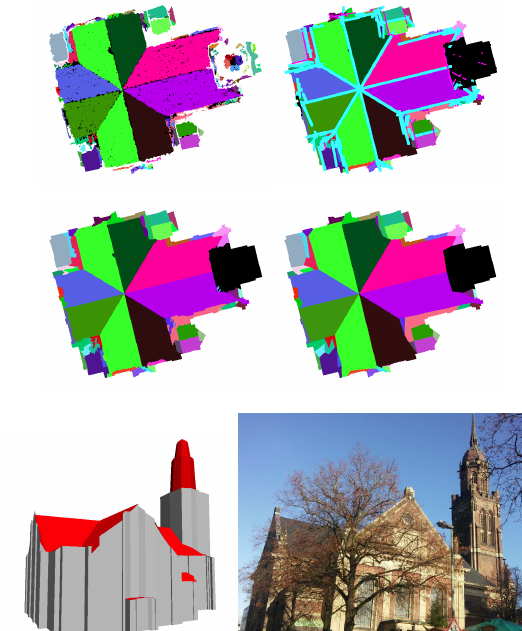
Figure 12: Starting with a raster map of pixels allocated to